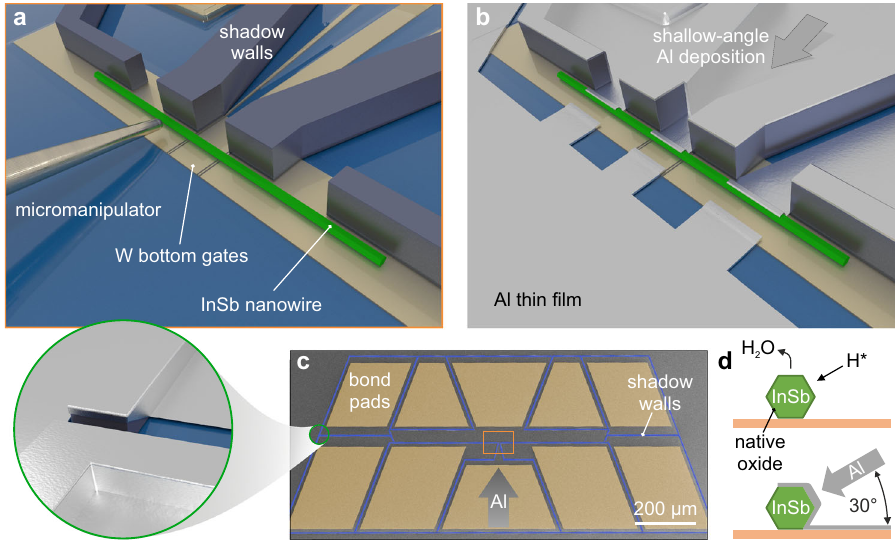
Fig. 1 Illustration of the shadow-wall technique. a Micromechanical transfer of the nanowires onto local bottom gates (covered by Al 2 O 3 dielectric) in the proximity of the Si 3 N 4 shadow walls. b Illustration of a fi nal device following the H radical cleaning and Al deposition at a shallow angle. c False-colour SEM image of an exemplary sample prior to Al deposition. Shadow walls are designated in blue and bond pads, which are enclosed by the shadow walls, are shaded in dark yellow. Gaps are placed at critical locations along the shadow walls (cf. green circle and the illustration in the blow-up following Al deposition). This ensures that bond pads with leads are isolated from each other after the Al deposition. The area illustrated in panel a is indicated by the orange box. d Schematic of the InSb nanowire cross-section during H radical cleaning (top). The native oxide of the semiconductor is denoted by a dark green layer. The Al thin fi lm deposited at a shallow angle of 30 ∘ forms an electrical connection from the nanowire to the substrate